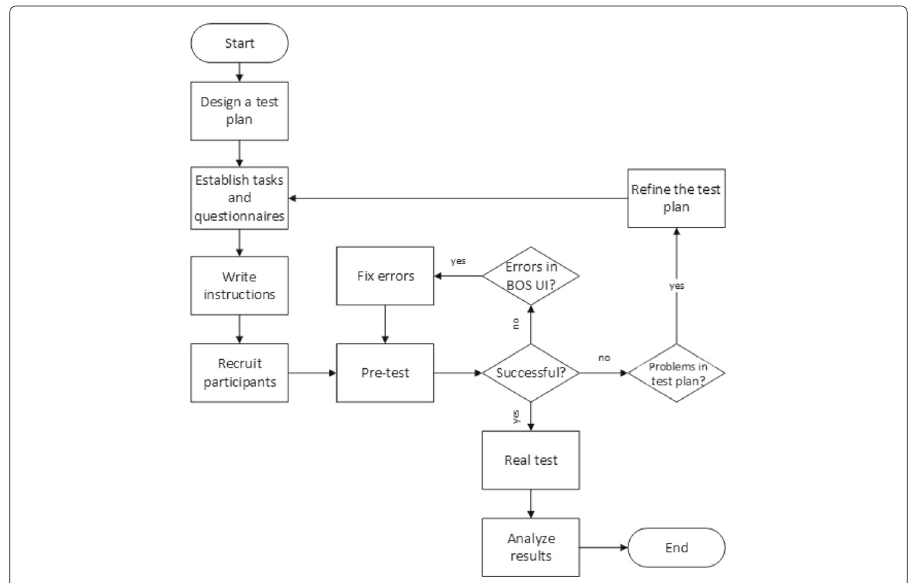
Fig. 27 The evaluation process of usability and functionality of the BOS